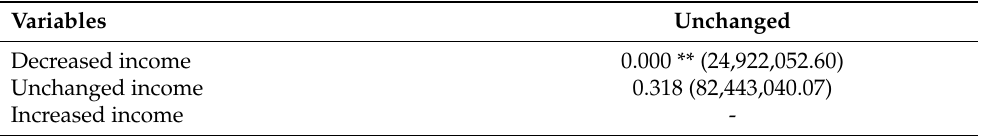
Table 6. Change in activity before and after the pandemic explained by the change of income.